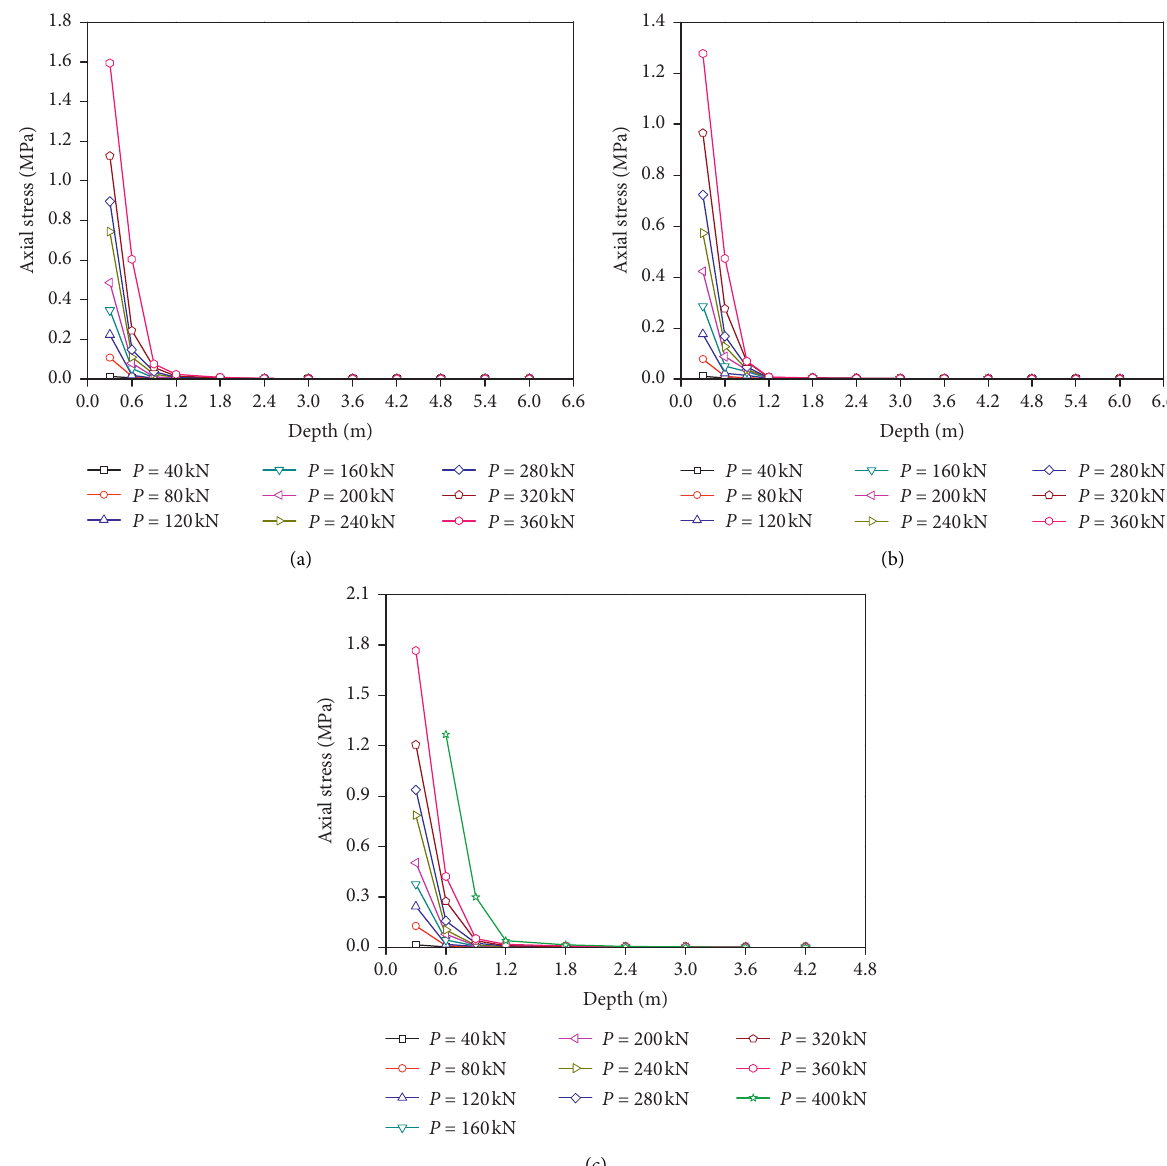
Figure 12: Axial stress of middle cross-section at different depths: (a) G-28-6.5-1, (b) G-28-6.5-2, and (c)